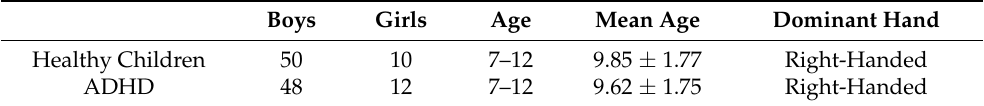
Table 2. Information about the participants [25].